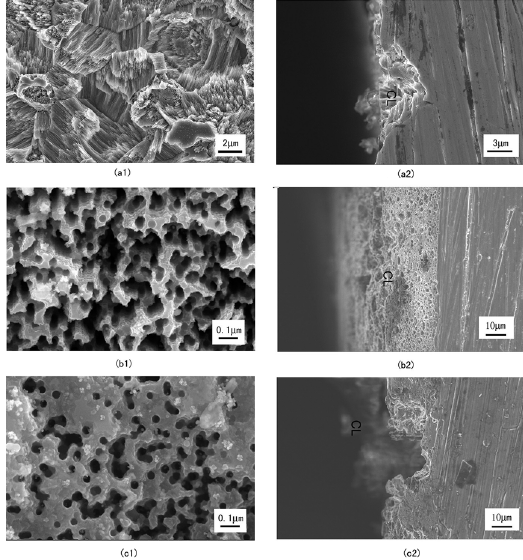
Figure 5. The surface and section morphology images of AZ31 magnesium alloy substrate observed by SEM after corrosion experiment in SBF (a, b and c are corresponding to 3 days, 10 days and 15 days corrosion, respectively. The left column of the figure is corresponding to surface morphology and the right column corresponding to section Figure 4. The surface morphology images of the films observed by SEM after heat treatment (a: Al film. b: TiO film). 2